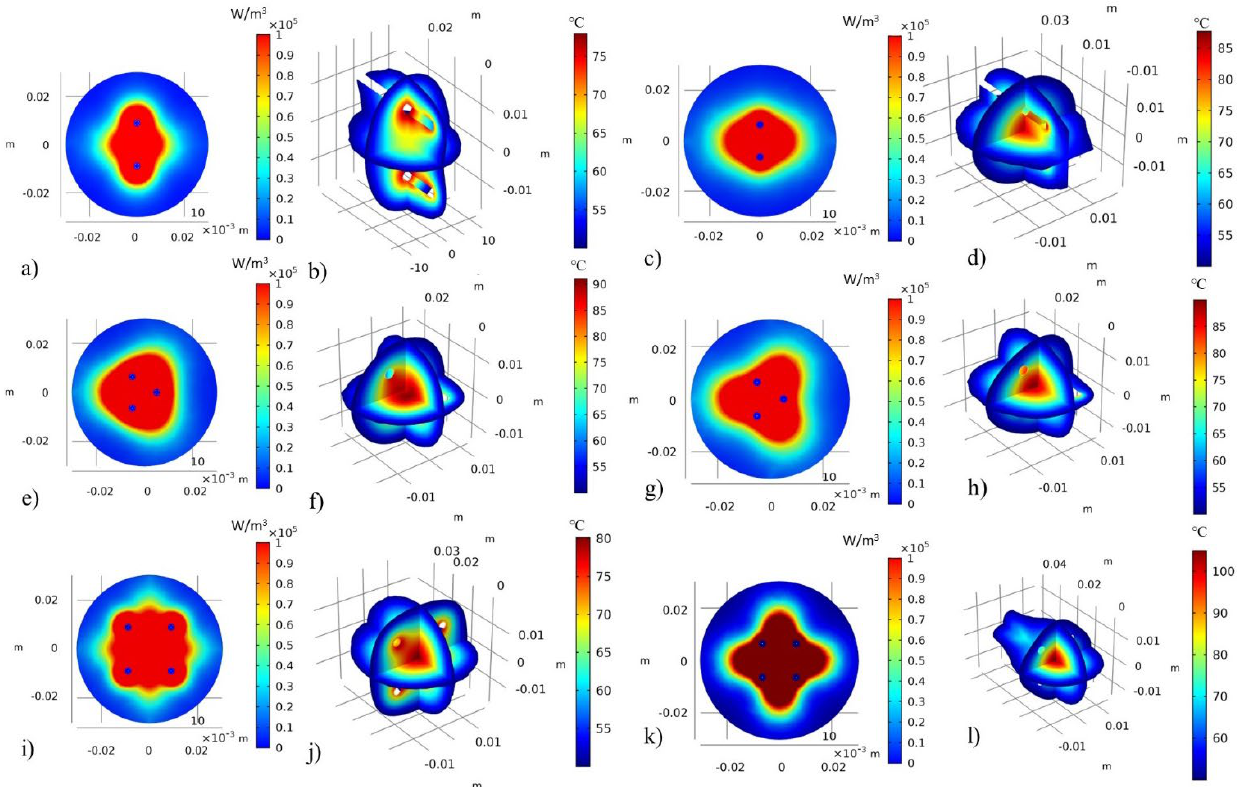
Figure 5. Distributions of the microwave heat source in the observation plane XY (W/cm 3 ) and 3D views of the thermal distribution at temperatures higher than 50 °C. ( a ) heat source field for a linear array of doble slot antennas ( ad = 15 mm and bt = 30 mm), ( b ) thermal distribution generated by the linear array of doble slot antennas ad = 15 mm and bt = 3 0 mm after 5 min, ( c ) heat source field for a linear array of monopole antennas ( ad = 10 mm and bt = 40 mm), ( d ) thermal distribution generated by the linear array of monopole antennas ( ad = 10 mm and bt = 40 mm) after 10 min, ( e ) heat source field for a triangular array of doble slot antennas ( ad = 10 mm and bt = 40 mm), ( f ) thermal distribu- tion generated by the triangular array of doble slot antennas ( ad = 10 mm and bt = 40 mm) after 5 min, ( g ) heat source field for a triangular array of monopole antennas ( ad = 10 mm and bt = 40 mm), ( h ) thermal distribution generated by the triangular array of monopole antennas ( ad = 10 mm and bt = 40 mm) after 5 min, ( i ) heat source field for a square array of doble slot antennas ( ad = 15 mm and bt = 40 mm), ( j ) thermal distribution generated by the square array of doble slot antennas ( ad = 15 mm and bt = 40 mm) after 10 min, ( k ) heat source field for a square array of monopole antennas ( ad = 10 mm and bt = 25 mm), ( l ) thermal distribution generated by the square array of monopole antennas ( ad = 10 mm and bt = 25 mm) after 5 min.